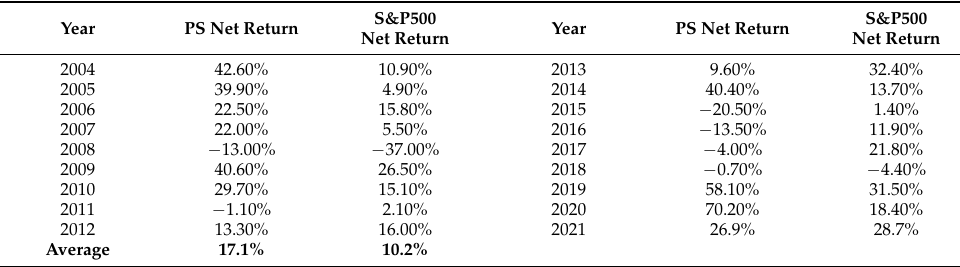
Table 1. Pershing Square Holdings (PSH) NAV Performance vs. the S&P500